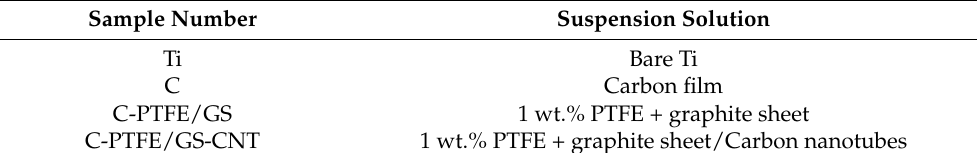
Table 1. The samples under different conditions of treatment.